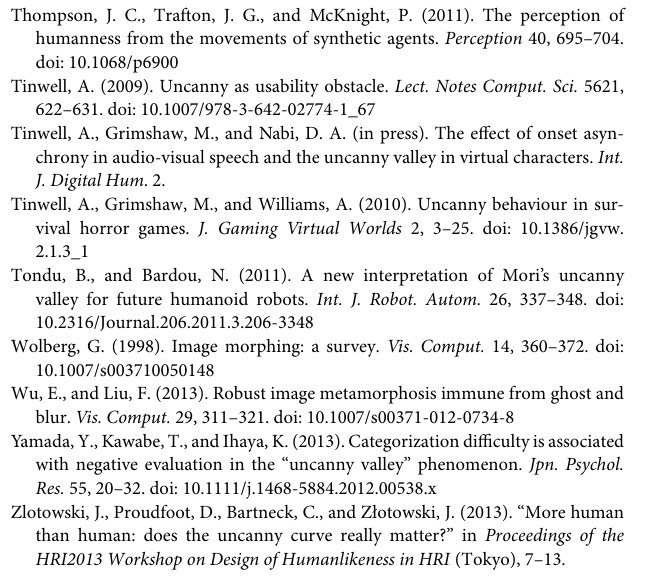
Conflict of Interest Statement: The authors declare that the research was con- ducted in the absence of any commercial or financial relationships that could be construed as a potential conflict of